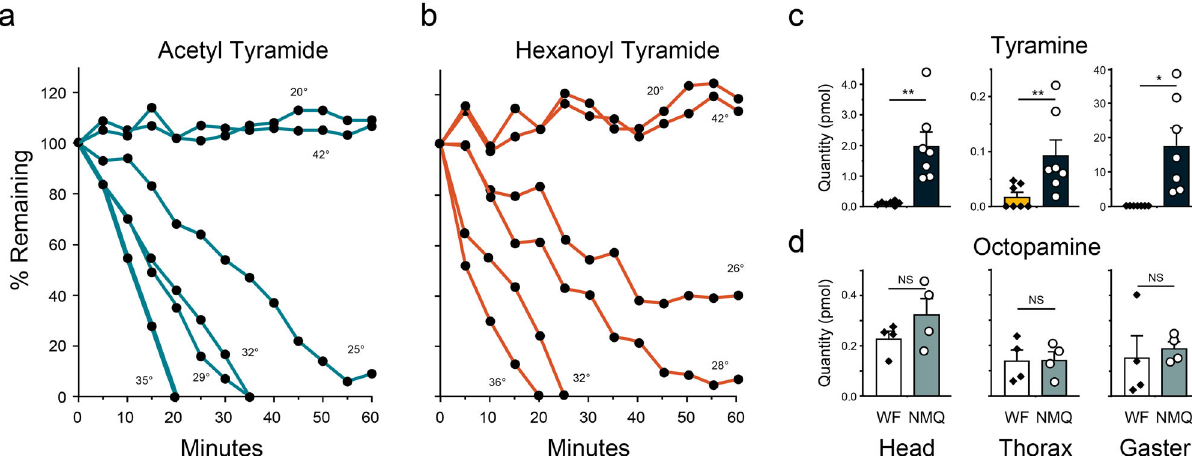
Fig. 3 The fate of tyramides transferred from male to female during mating. Extracts of dissected vulva/bursa copulatrix (see Supplementary Fig. 2-I red oval) from winged females (WF) > 15 mg) were incubated with synthetic tyramides a acetyl- and b hexanoyl-, at various temperatures and the percent loss of tyramides determined over time. c Shows the quantity of tyramine in winged female and NMQ parts (head, thorax, and gaster) compared with Welch ’ s t-test and Mann − Whitney test, n = 7; note differing scales on the y -axes. d Shows the quantity of another biogenic amine, octopamine, from four of the same winged females and NMQ samples used for tyramine analyses (compared with t-test, n = 4). Bars represent mean + SEM, circles represent individual NMQs, diamonds represent individual winged females (WF)s, * p < 0.05; ** p < 0.01, NS not signi fi cant.